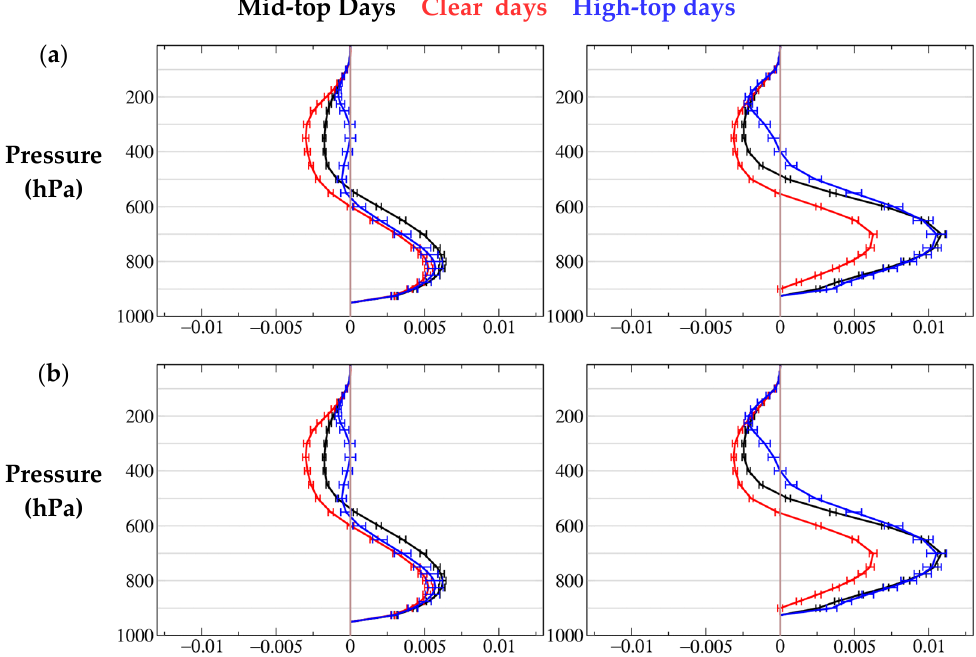
Figure 14. ( a ) Mean vertical profile of vertical mass flux in kg/m 2 /s for Saharan atmospheric boundary layer (SABL)-like profiles. ( b ) mean vertical profile of horizontal water vapor flux rate value in kg/m 2 /d for SAB-like profiles and at the top of Y axis the integrated value over the whole vertical column (surface to 70 hPa; SUM). Average over the JJAS period. Statistical uncertainty of the mean values (horizontal bars). Information is given for mid-top days (black), clear days (red) and high-top days for West-Sahara (left column) and Hoggar (right column). In ( a ) the sign of the flux is positive for ascending flux and negative for subsiding flux. In ( b ) the sign of the flux rate is positive for convergence and negative for divergence.